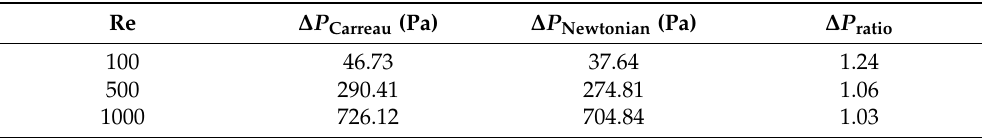
Table 2. Pressure drop for both rheological models.